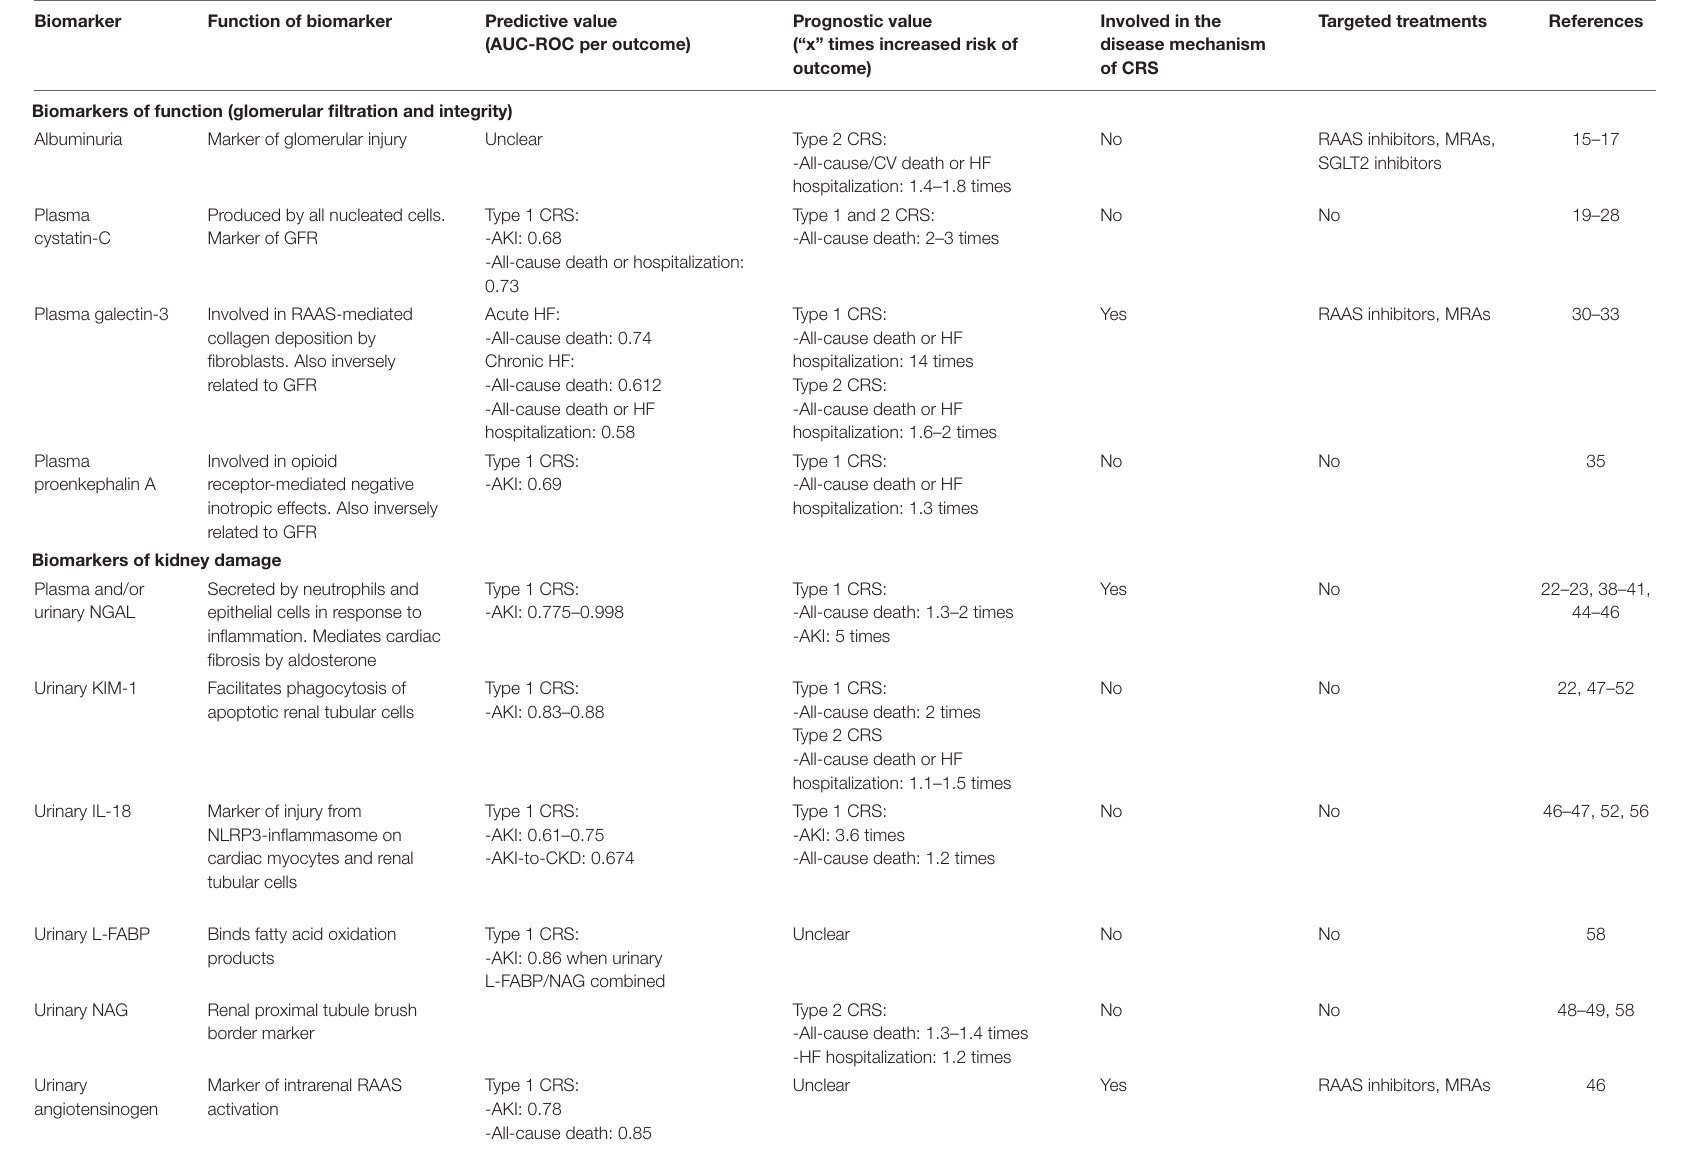
TABLE 1 | Biomarkers in cardiorenal